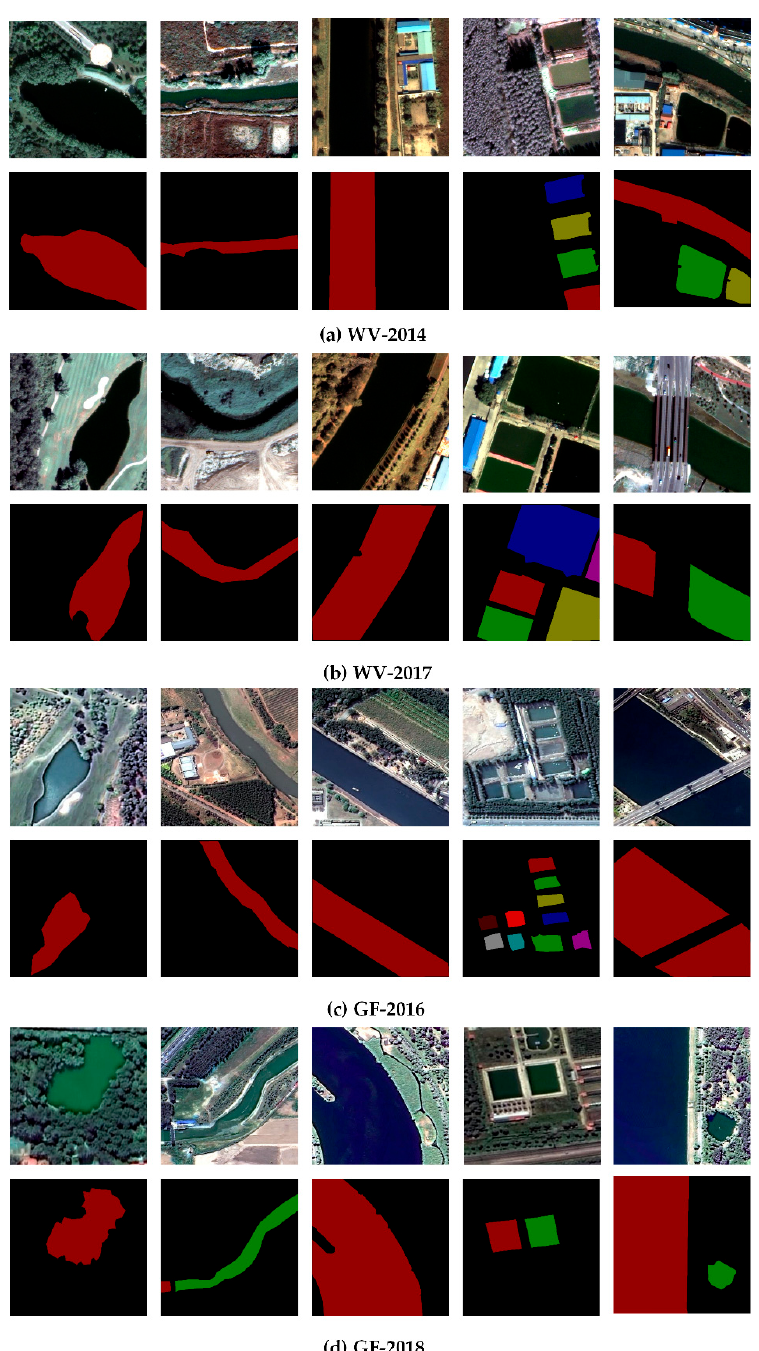
Figure 12. Examples of the WV-2014 ( a ), WV-2017 ( b ), GF-2016 ( c ), GF-2018 ( d ) sub-datasets. From top to bottom: image, label. From left to right: water bodies with di ff erent morphological